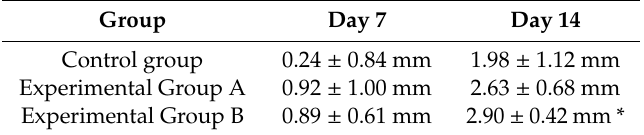
Figure 4. Star plot of global protein expression in Saos-2 cells treated with 4HR for 24 h. The expression level (%) of osteogenesis-related proteins ( n = 23) were sequentially dominant (in accordance with the four stages of osteogenesis) at 8 (orange dots), 16 (pink dots), and 24 h (red and blue dots) after 4HR treatment compared to the non-treated control. Table 1. Intergroup comparison of distance of tooth movement.